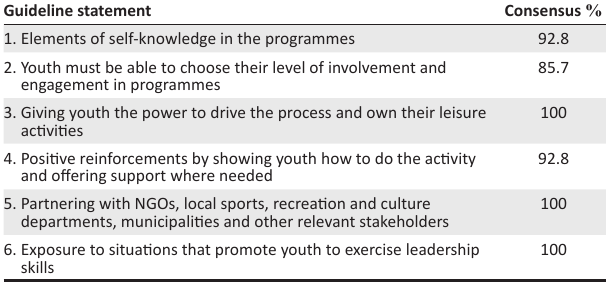
TABLE 4: Guidelines for youth with physical disabilities to realise their leadership skills.